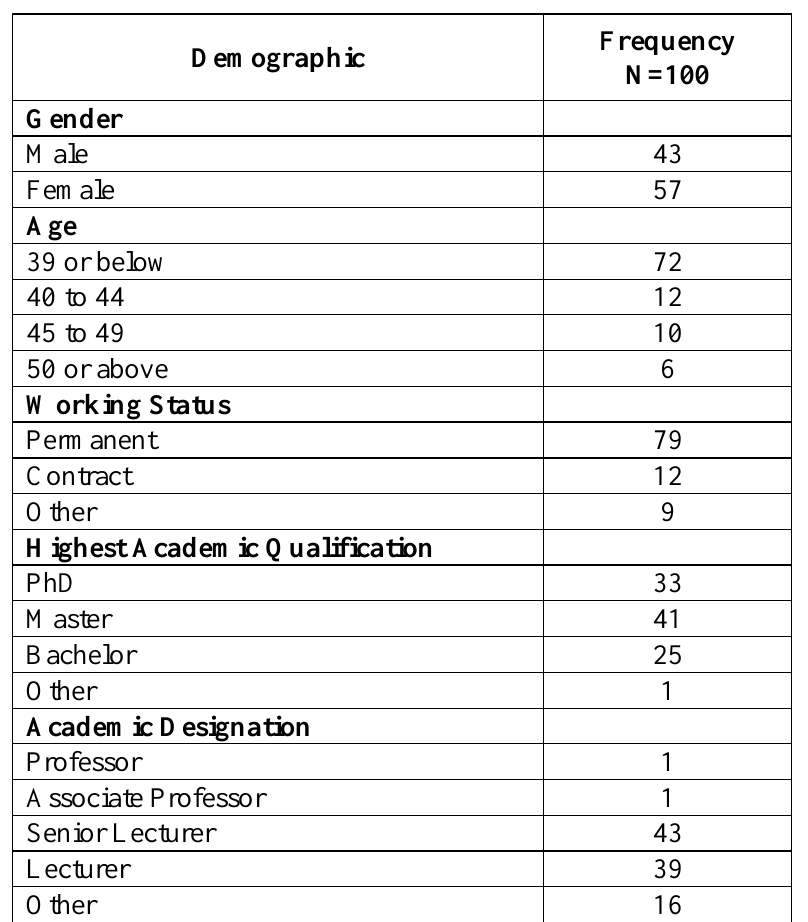
Table 01: 1Demographic Characteristics and Frequency Distributions of